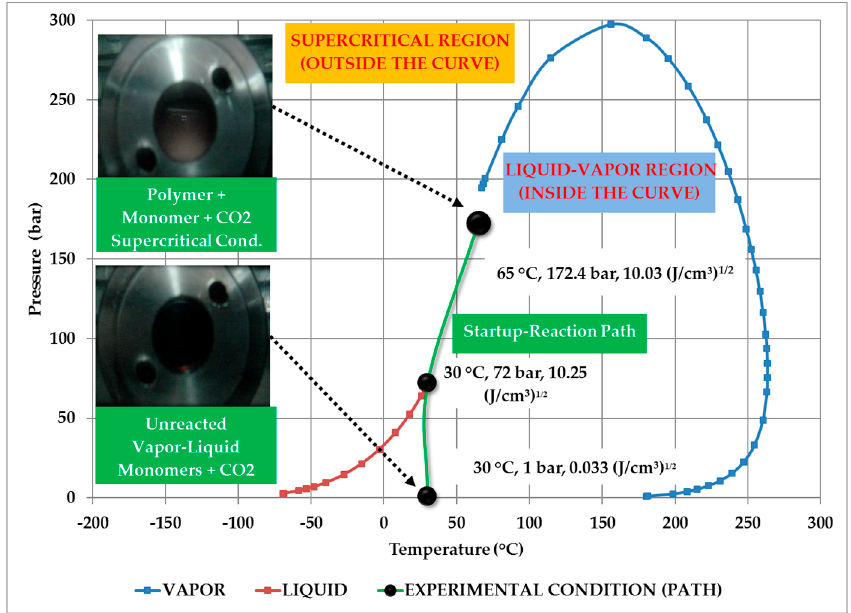
Figure 1. Pressure vs. temperature diagram for the system carbon dioxide, HEMA, EGDMA, AIBN, including the path followed by the reactor and the solubility parameter values estimated at each point using an equation of state, generated with ASPEN PLUS.